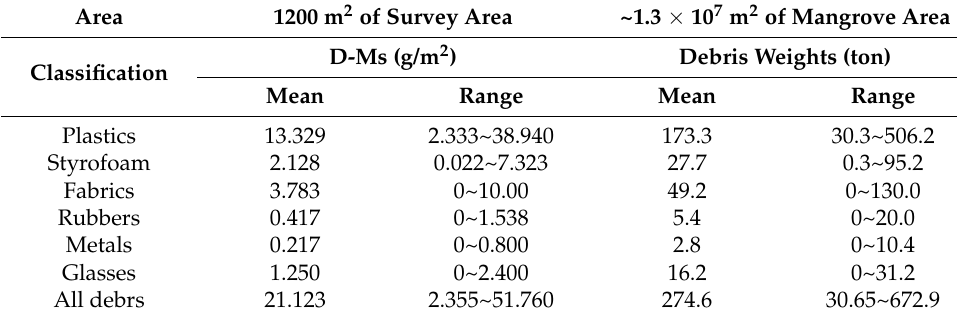
Table 5. The debris weights estimated in Beilun Estuary mangrove forest region.